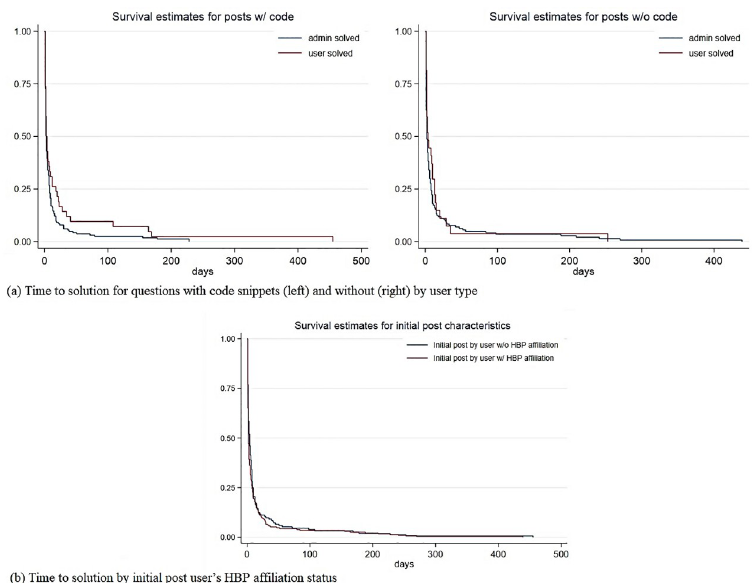
Fig 3. Kaplan-Meier non-parametric survival analyses. Notes: This figure reports a set of main graphical results from the survival analyses to disentangle what factors are most relevant for effective problem solving in online platforms. Additional graphs on other factors in the hazard and time-to-event analyses are available upon